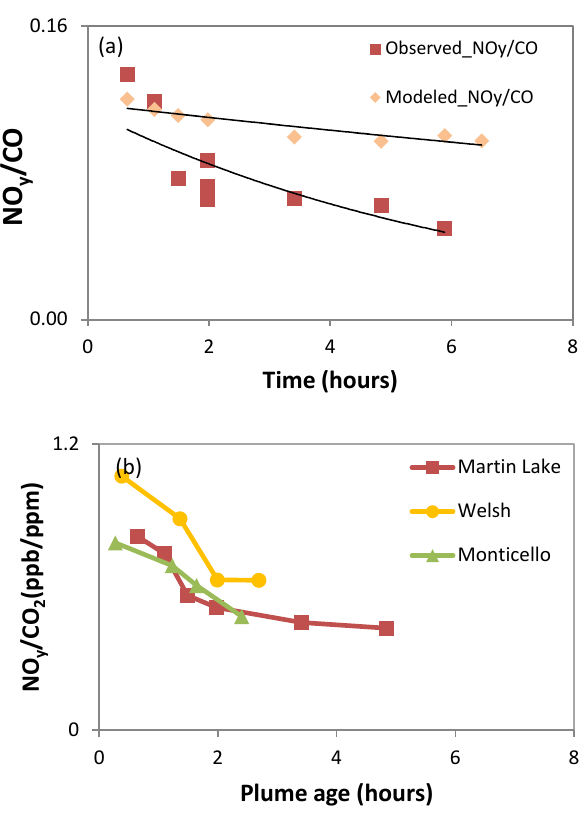
Fig. 7. (a) The observed least square slopes of NO y to CO (red square) and modeled ZOC NOy /ZOC CO (orange diamond for the base case, green dot for the adjusted cloud case) as a function of plume age at each transect of the Martin Lake plume; the observed NO y loss rate was 0.145h − 1 ( R 2 =0.69) and the modeled NO y loss rate was 0.026h − 1 ( R 2 =0.48). (b) The observed least square slopes of NO y to CO 2 (ppbppm − 1 ) for the Martin Lake, Monticello, and Welsh. NO y in the least-square fits was directly measured and not the sum of measured reactive nitrogen species.